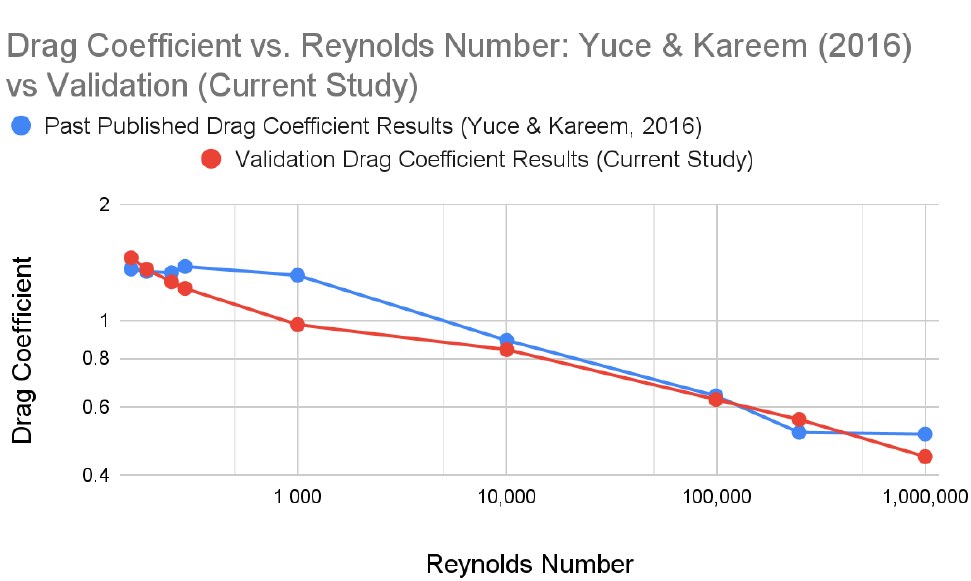
Figure 8. Graph Comparing Drag Coefficient Results: Yuce & Kareem [10] vs. Validation.